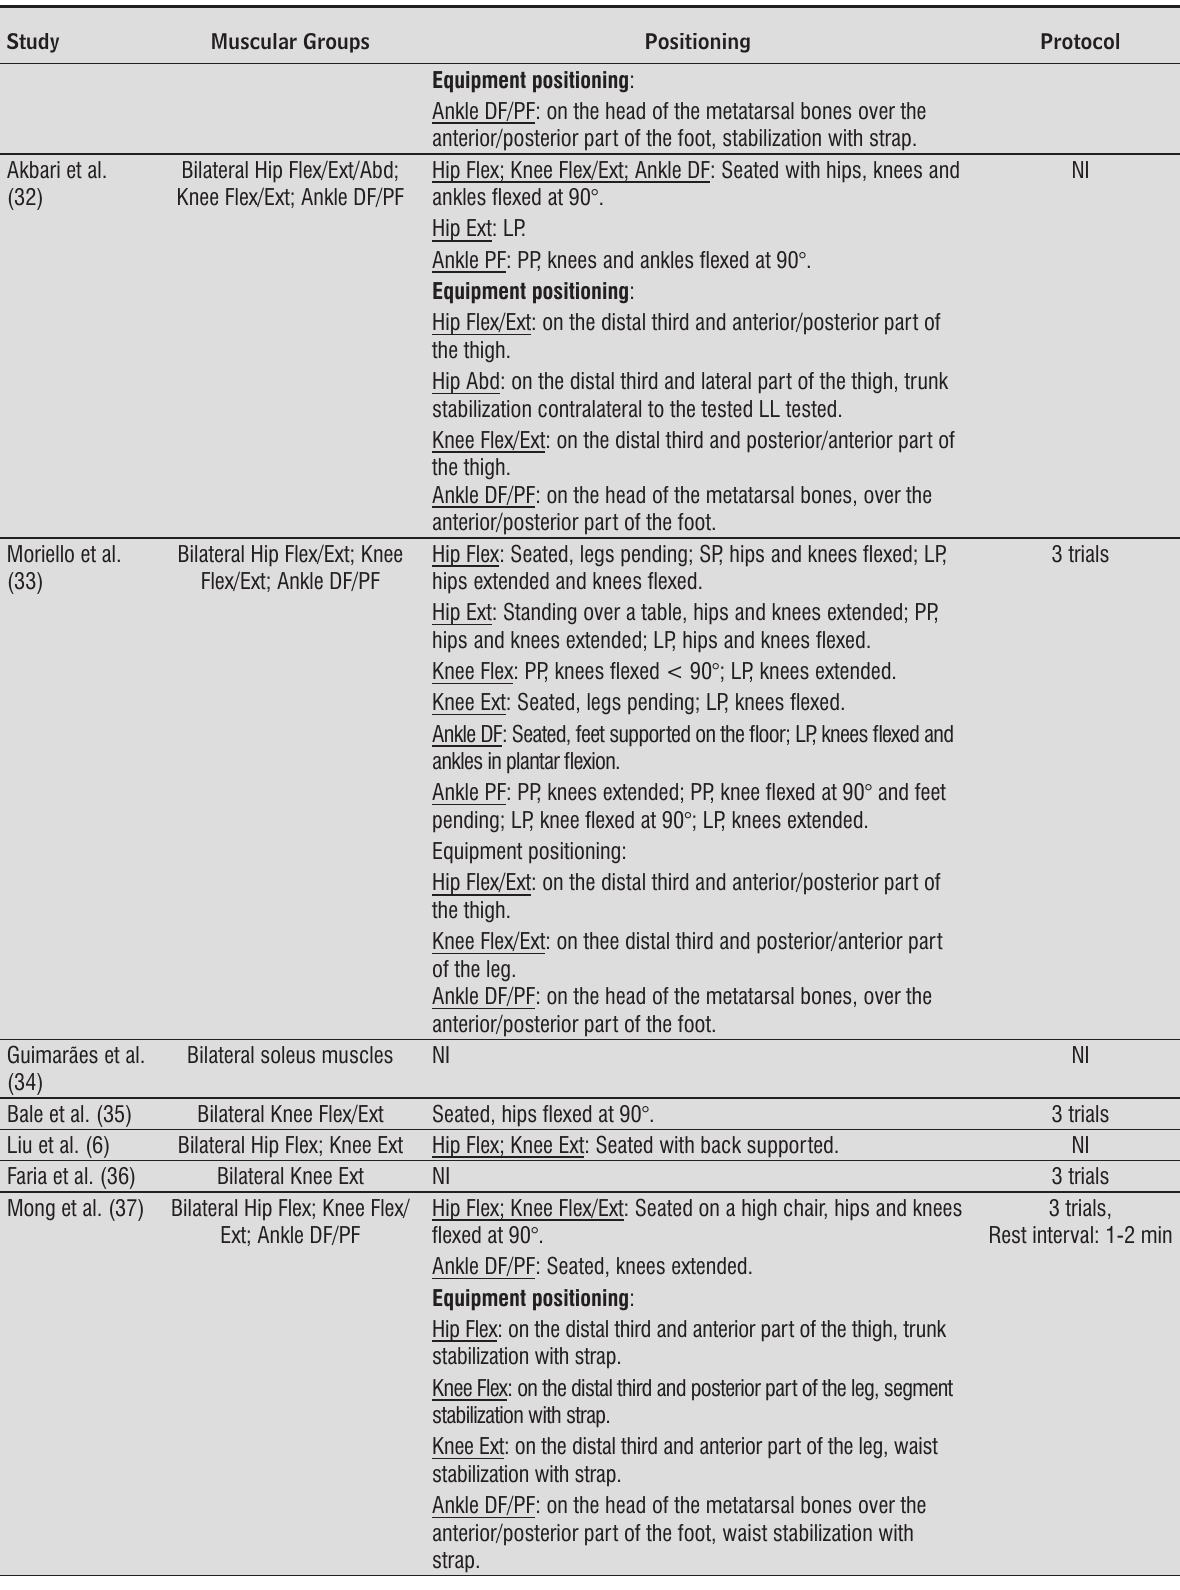
Table 2 - Data extraction of the 30 studies, which assessed the strength of the lower limb muscles with portable dynamometry in subjects with stroke and provided information regarding the positioning or the data